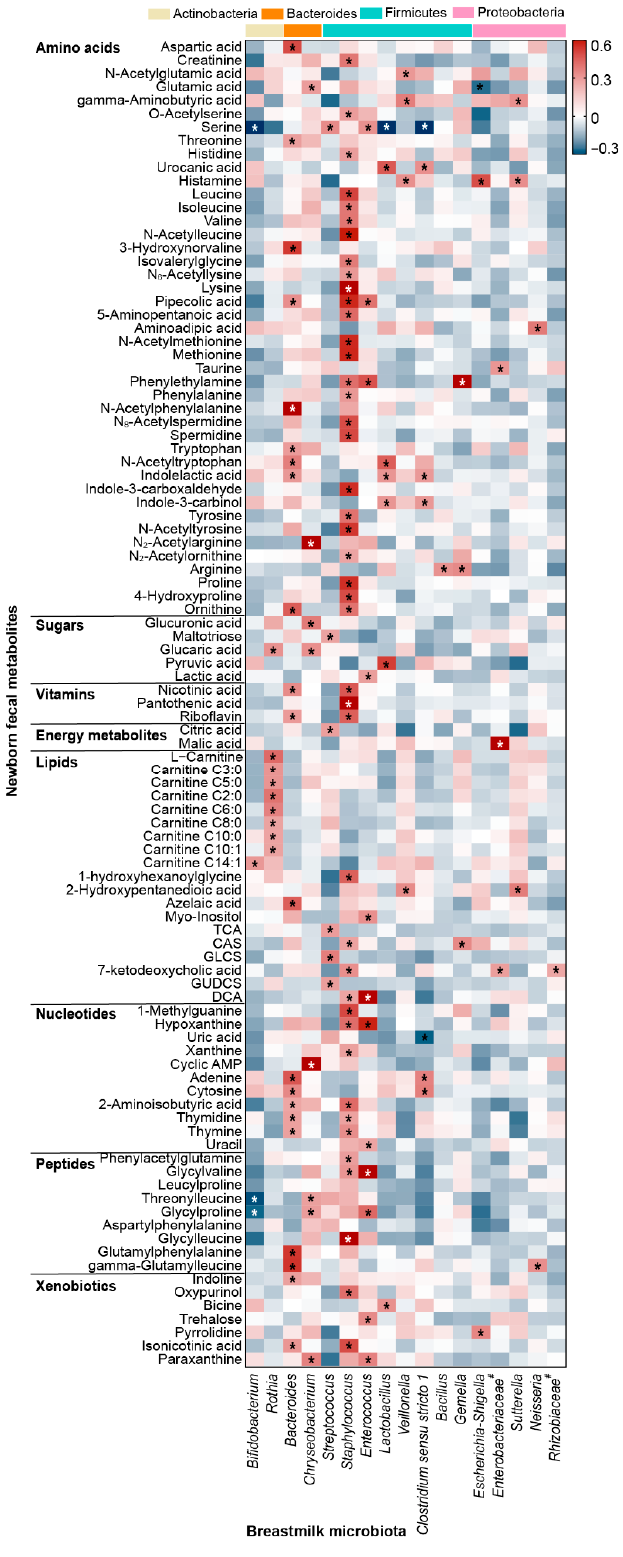
Figure 2. Heatmap of partial correlation analysis between breastmilk microbiota and the neonatal fecal metabolome. Correlations with |R 1 | > 0.2 and p < 0.05 are marked with an asterisk (*). Pound sign (#) indicates the unclassified bacteria at the genus level.